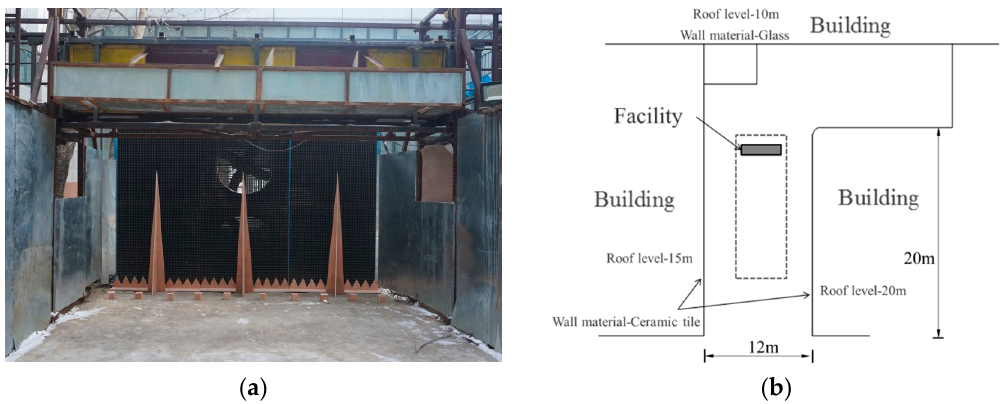
Figure 1. ( a ) Photo of the snow–wind combined experiment facility. ( b ) Location of the facility.